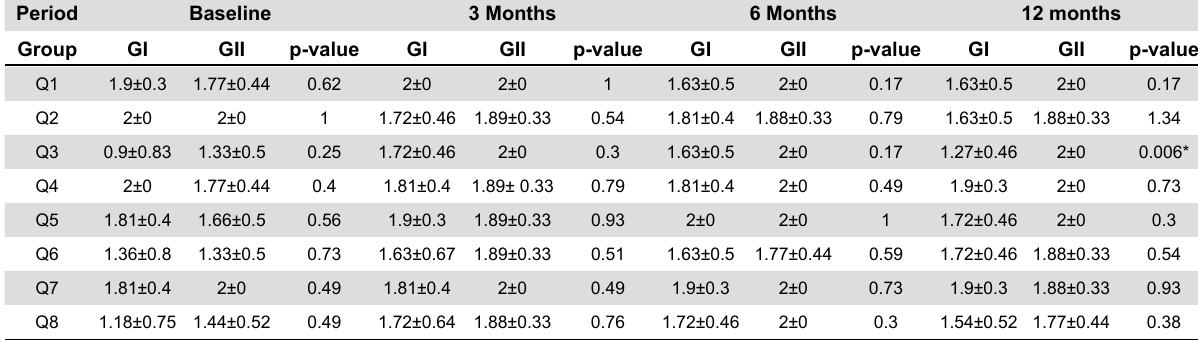
Table 3- Values for questions of the satisfaction questionnaire. Comparison between groups (mean±standard deviation)